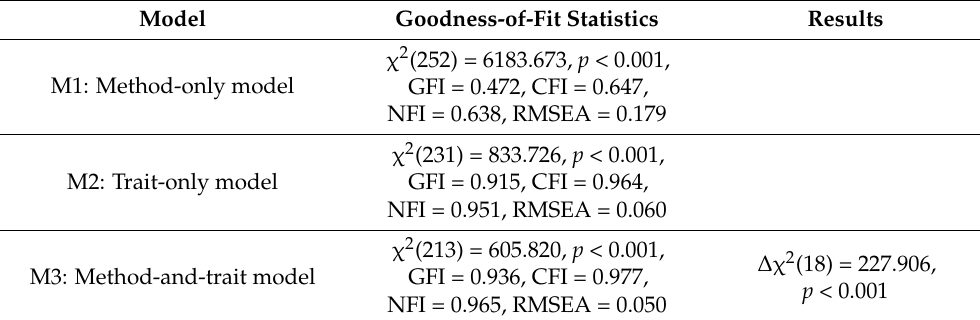
Table 6. Test of Common Method Bias.